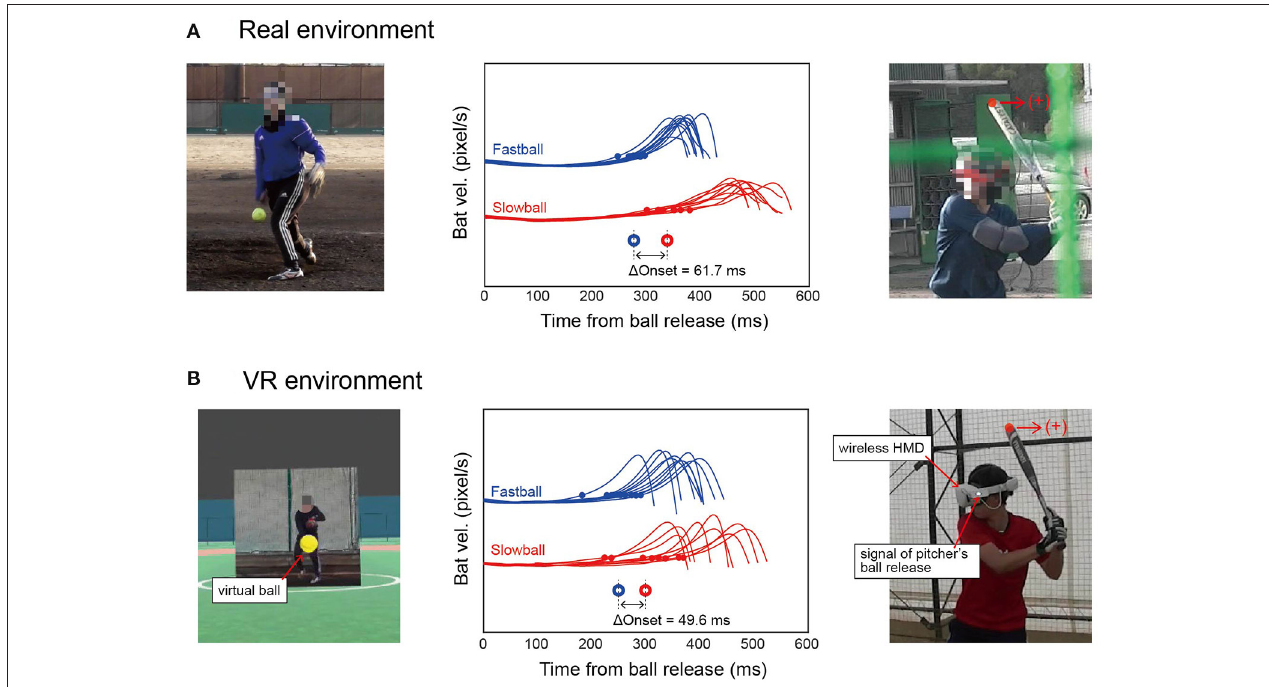
FIGURE 1 | Experimental environments and time curves of bat velocities. (A) In the real environment, a batter hit balls thrown by a real pitcher. The right panel is a video image for identifying the batter’s swing onset with the tip of the bat labeled (red dot). The center panel shows the time curves of the bat velocities in the catcher’s direction, where the small dots are the swing onset and the large open circles are their average for each type of pitch. (B) In the VR environment, a batter swung at the balls thrown by a virtual pitcher. The left panel is a pitcher as seen by a batter in the VR. In the right panel, the pitcher’s ball release was identified by the LED signal. The notation is the same as in (A)